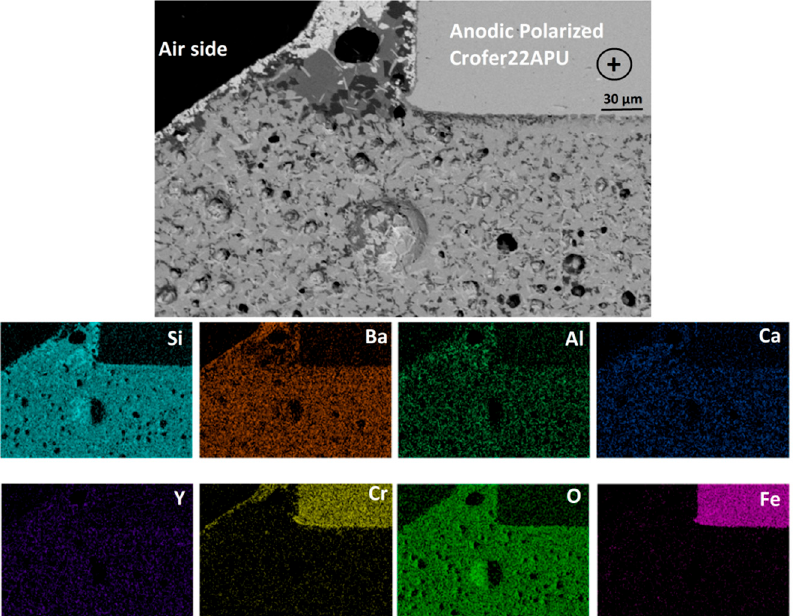
Figure 7. SEM-EDS post mortem analysis at anodic polarized Crofer22APU / HJ28 glass-ceramic interface Figure 7. SEM ‐ EDS post mortem analysis at anodic polarized Crofer22APU/HJ28 glass ‐ ceramic after the dual test, collected at air interface after the dual test, collected at air side.